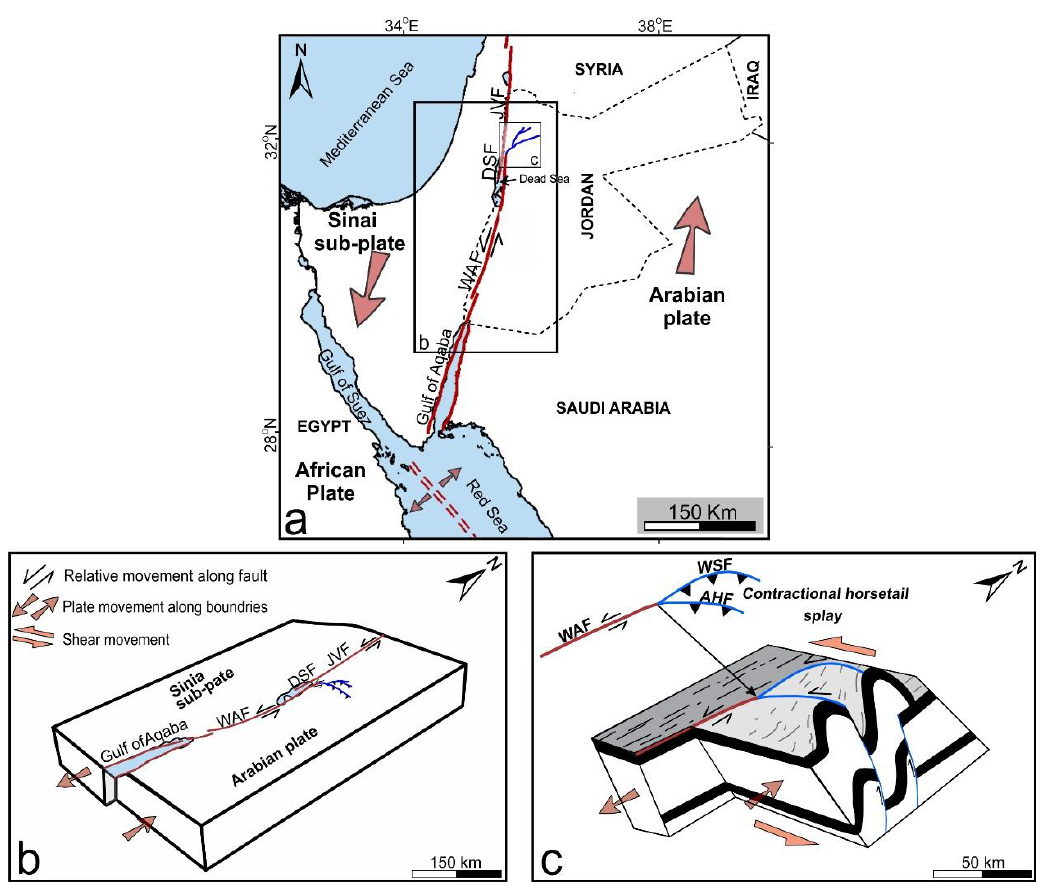
Figure 10. ( a ) Tectonic map of the eastern Mediterranean, showing the plate boundaries and major segments of the DSTF along the Jordan (compiled from [37,38,41,45]). ( b ) The simplified sketch shows how the Wadi Shueib and Amman-Hallabat Faults splay as horsetail structures from the WAF. ( c ) The conceptual model illustrates the transpressional Wadi Shueib and Amman-Hallabat Faults along with the northern termination of the WAF (the model has no vertical exaggeration). The model suggests that both structures are reactivated splays within the area of the restraining bend. Fault splays comprising contractional horsetail structures. Depending on the direction of curvature to the sense of displacement, thrust components of displacement occur on faults of the horsetail, and these movements are accompanied by folding and uplifting. AHF: Amman-Hallabat Fault; DSF: Dead Sea Fault; JVF: Jordan Valley Fault; WAF: Wadi Araba Fault; WSF: Wadi Shueib Fault.